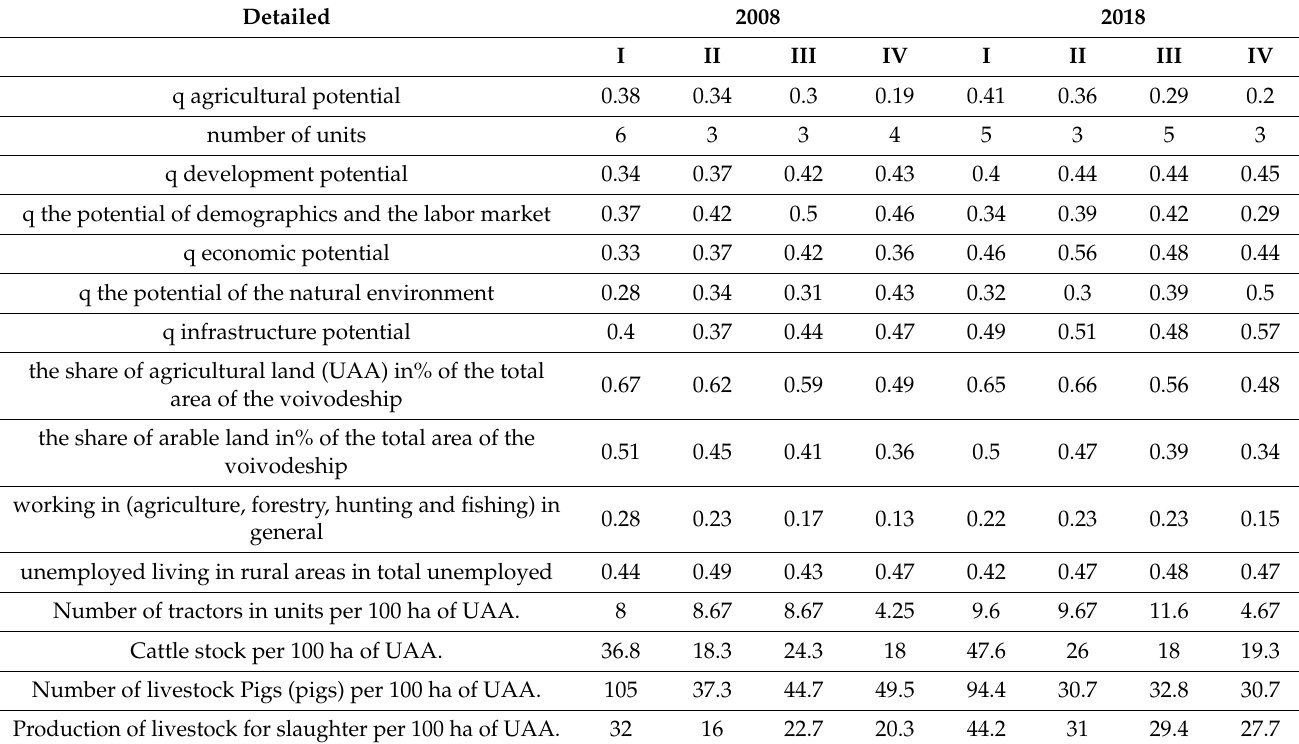
Table 4. Values of indicators describing the situation of the agricultural potential and development of Polish voivodships in 2008 and 2018 (according to the average value for quartile